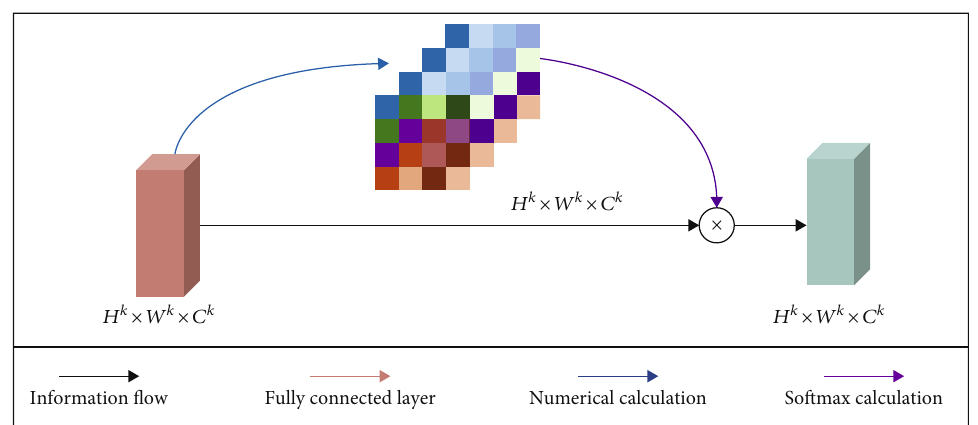
Figure 3: Parameter-free self-attention mechanism that constitutes our FTM.